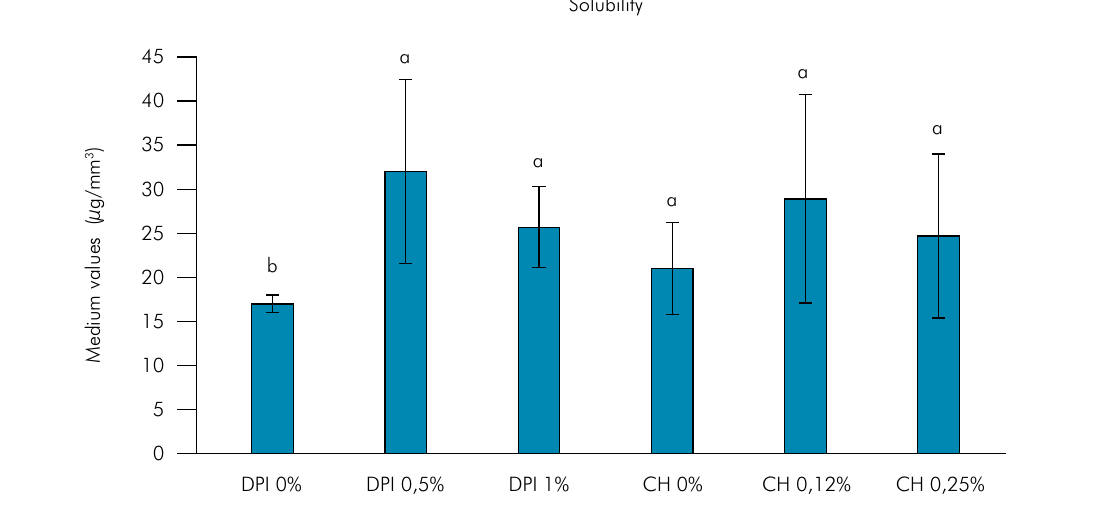
Figure 5. Mean values of solubility ( μ g/mm 3 ) of experimental infiltrants, according to DPI (mol%) and chitosan (w%)